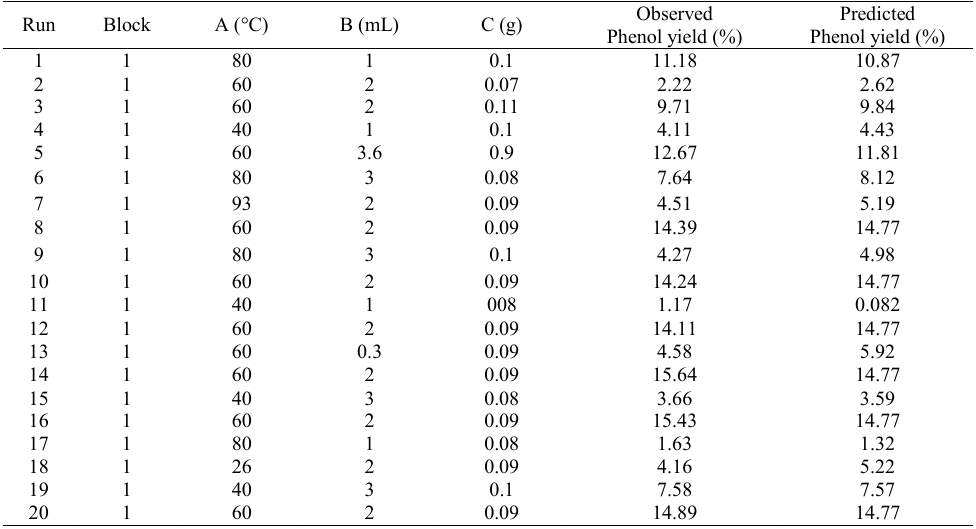
Table 2. The design experiment matrix based on central composite design (CCD). a